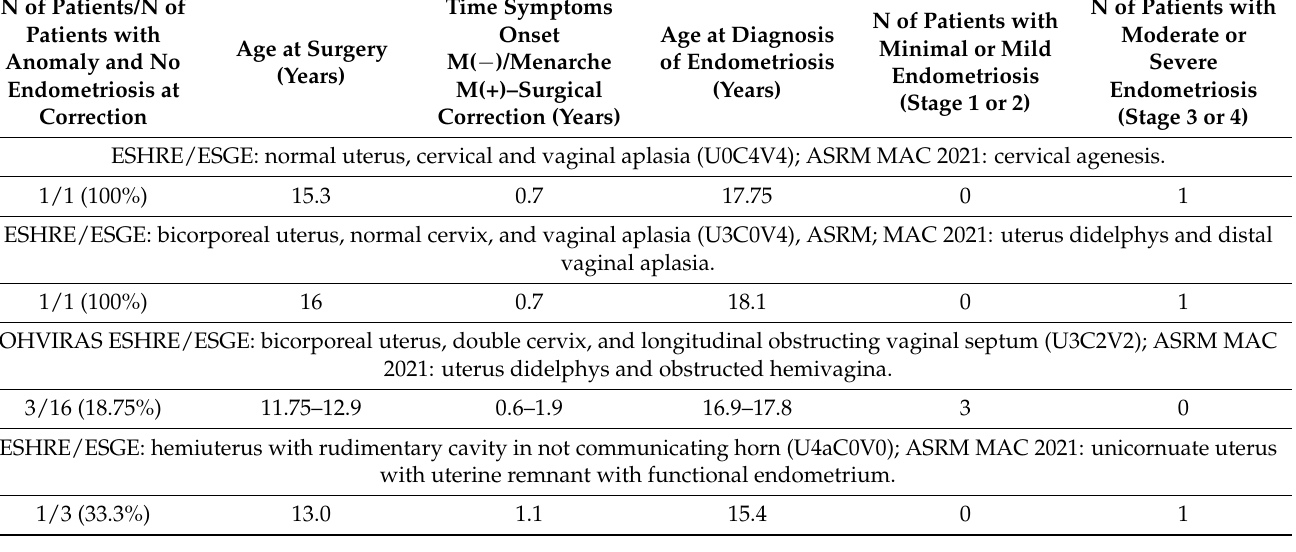
gical correction and during follow-up, and (3) girls with persistent dysmenorrhea and without persistent dysmenorrhea for, (1) the age at surgery, (2) age at the onset of symptoms (in patients without menses) or age at menarche (in patients with menses), and (3) delay from symptoms onset (in patients without menses) or menarche (in patients with menses) (Table 5). Adolescents with persistent dysmenorrhea were older at the last follow-up visit than adolescents without menstrual pain ( p = 0.004). The duration of follow-up was longer in girls with endometriosis ( p = 0.027) and in adolescents with persistent dysmenorrhea ( p = 0.001) (Table